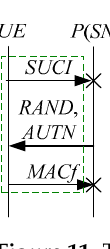
Figure 11. The tenth attack scenario of the 5G AKA protocol. In Figure 11, the green dashed box represents the initiator strand of Theorem 3. Ac- cording to Figure 11, UE does not authenticate SN and HN . The penetrator P can perform a masquerading attack, where